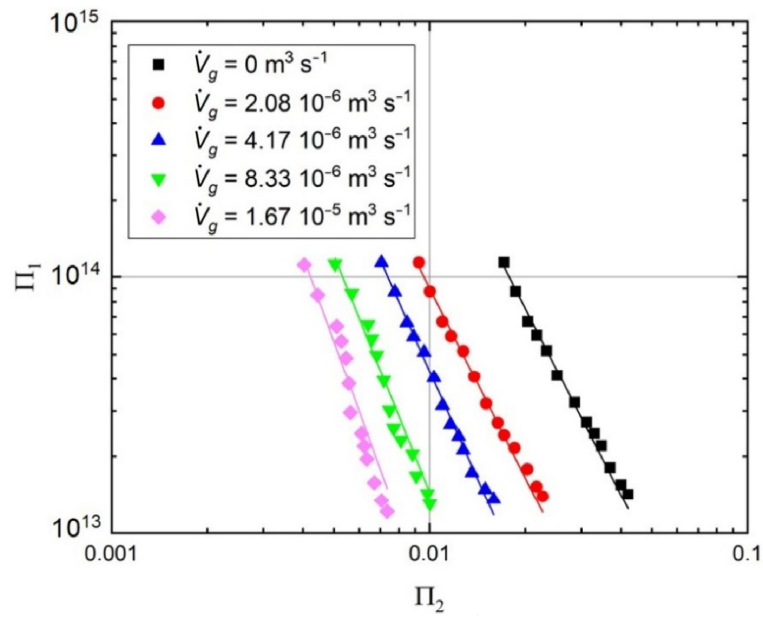
Figure 3. The dependence between the dimensionless numbers Π 1 and Π 2